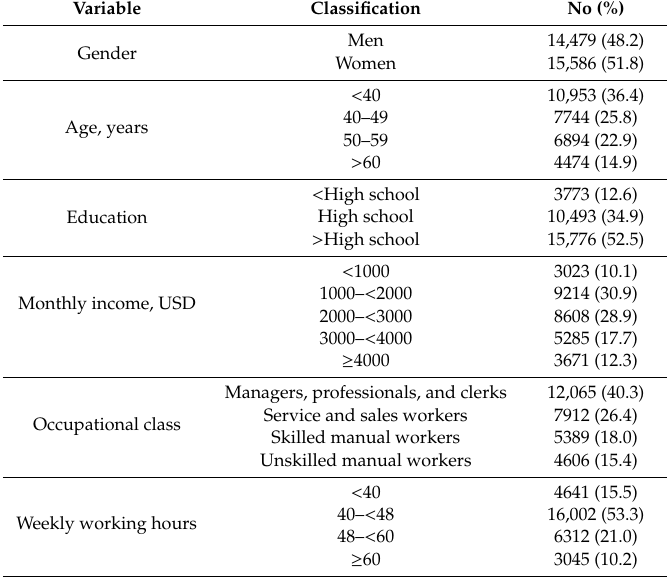
Table 1. Socio-demographic characteristics of study subjects (N =